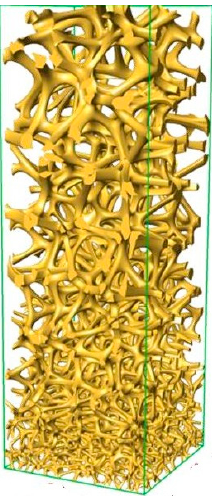
Figure 18. Gradient lattice structure generated by top-down Voronoi-tessellation method [186].